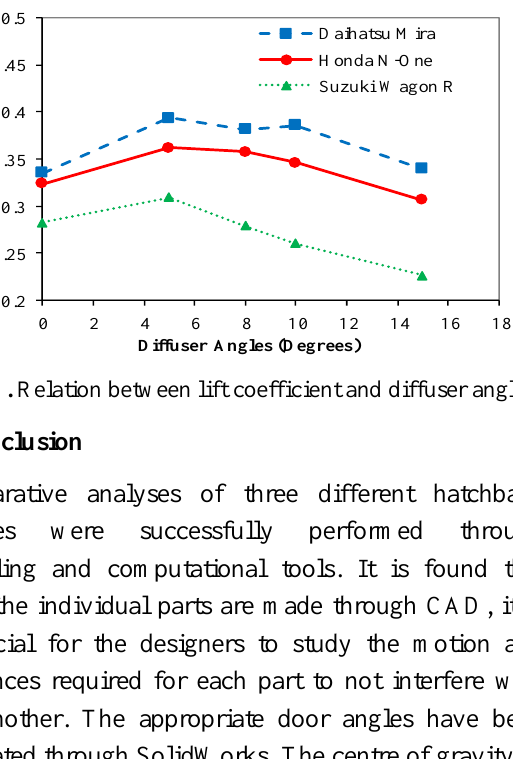
Fig. 20. Relation between drag coefficient and diffuser angles